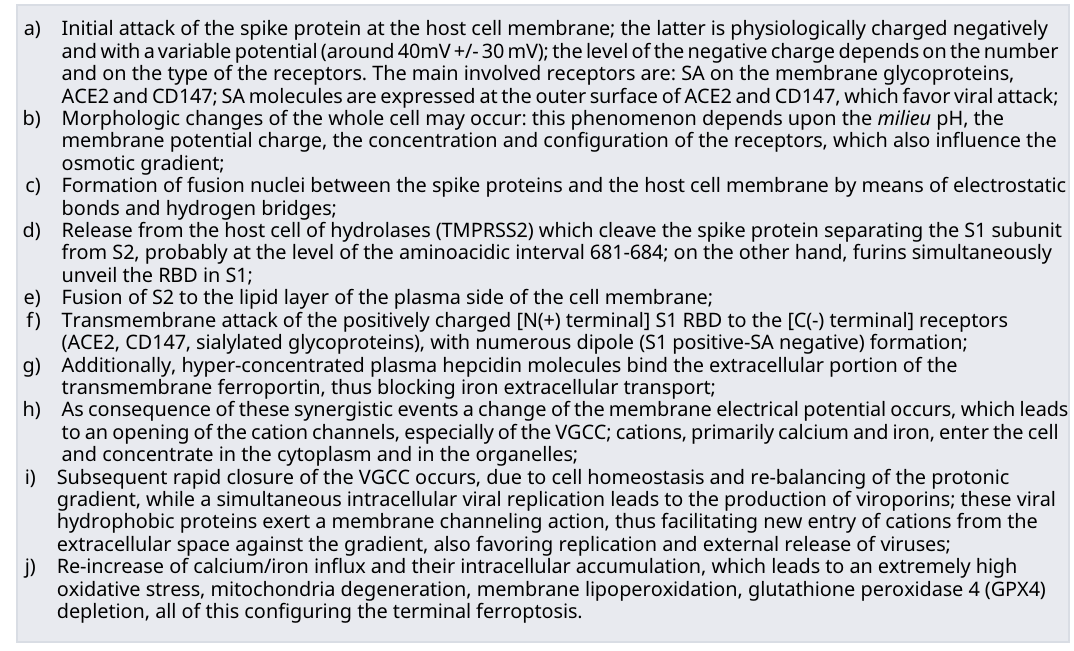
Table 1. Main pathological steps of the SARS-CoV-2 attack to cell membrane and of consequent cell degeneration. a) Initial attack of the spike protein at the host cell membrane; the latter is physiologically charged negatively andwithavariablepotential(around40mV+/-30mV);thelevelofthenegativechargedependsonthenumber and on the type of the receptors. The main involved receptors are: SA on the membrane glycoproteins, ACE2 andCD147; SA moleculesareexpressed atthe outersurface of ACE2and CD147,which favorviral attack; b) Morphologic changes of the whole cell may occur: this phenomenon depends upon the milieu pH, the membrane potential charge, the concentration and configuration of the receptors, which also influence the osmotic gradient; c) Formation of fusion nuclei between the spike proteins and the host cell membrane by means of electrostatic bonds and hydrogen bridges; d) Release from the host cell of hydrolases (TMPRSS2) which cleave the spike protein separating the S1 subunit from S2, probably at the level of the aminoacidic interval 681-684; on the other hand, furins simultaneously unveil the RBD in S1; e) Fusion of S2 to the lipid layer of the plasma side of the cell membrane; f) Transmembrane attack of the positively charged [N(+) terminal] S1 RBD to the [C(-) terminal] receptors (ACE2, CD147, sialylated glycoproteins), with numerous dipole (S1 positive-SA negative) formation; g) Additionally, hyper-concentrated plasma hepcidin molecules bind the extracellular portion of the transmembrane ferroportin, thus blocking iron extracellular transport; h) As consequence of these synergistic events a change of the membrane electrical potential occurs, which leads to an opening of the cation channels, especially of the VGCC; cations, primarily calcium and iron, enter the cell and concentrate in the cytoplasm and in the organelles; i) Subsequent rapid closure of the VGCC occurs, due to cell homeostasis and re-balancing of the